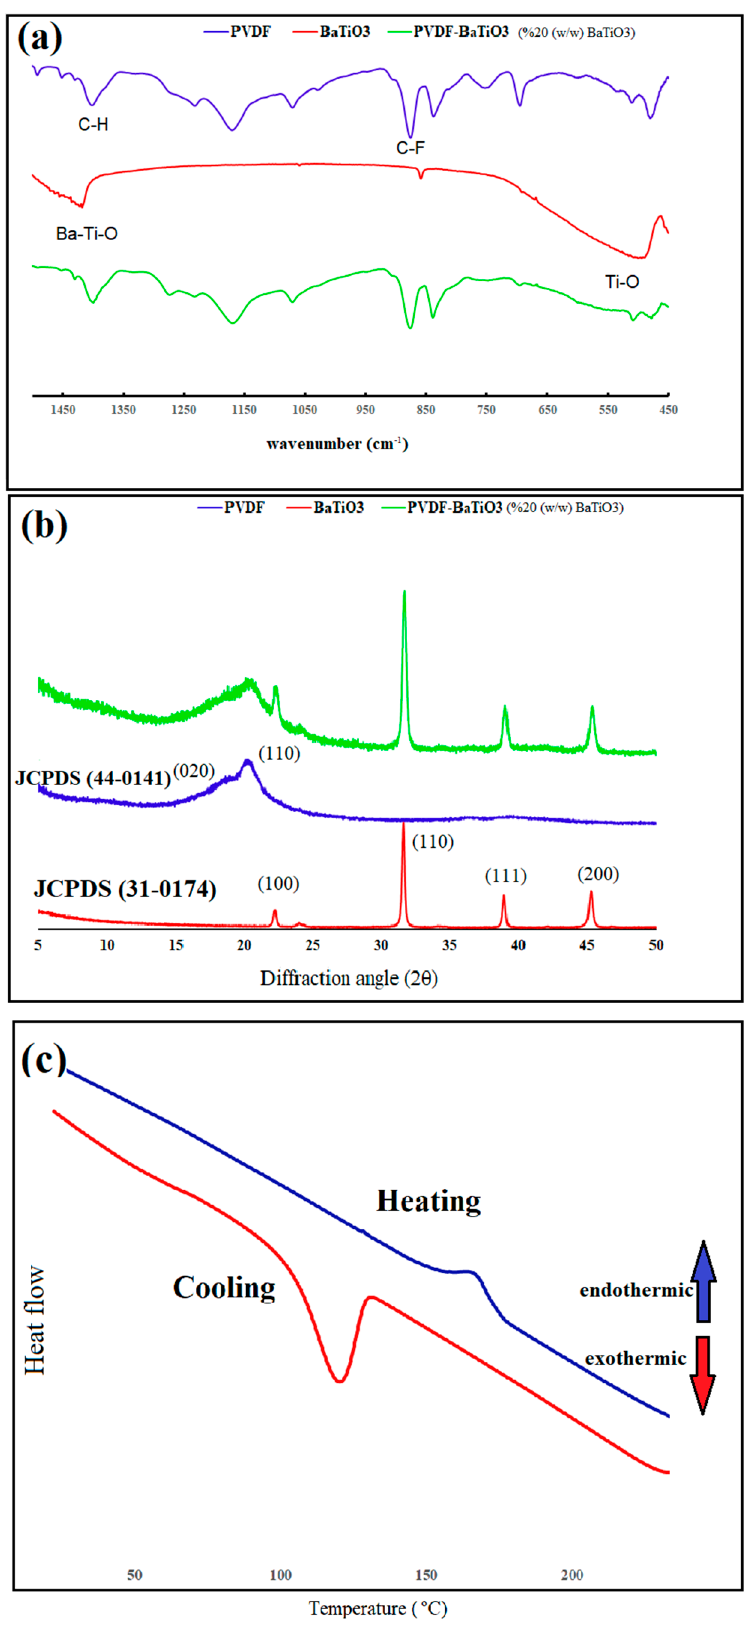
Figure 2. ( a ) FT-IR and ( b ) XRD spectra of polyvinylidene difluoride (PVDF), BaTiO3, and PVDF-BaTiO 3 nanocomposite, ( c ) DSC thermogram of the nanocomposite with 20% BaTiO 3 content.